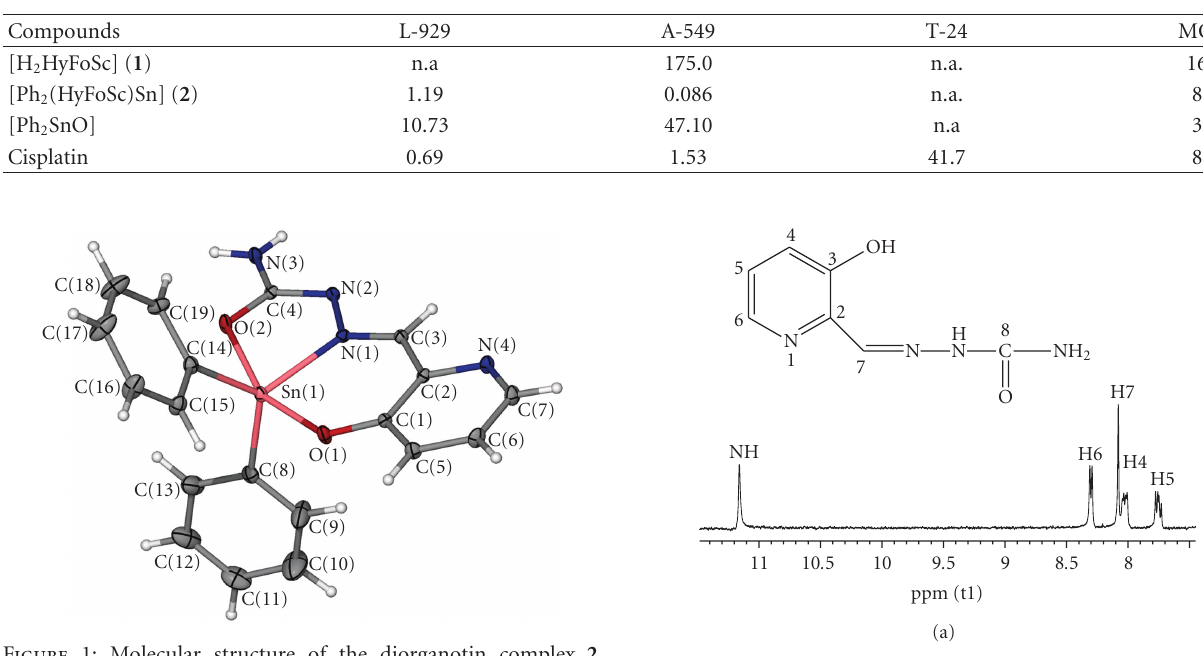
Table 4: The antiproliferative activity in vitro of H 2 HyFoSc and its organotin complex 2 (expressed as ID 50 ( μ M)) against MCF-7, T-24, A-549, and L-929 cancer cell lines.